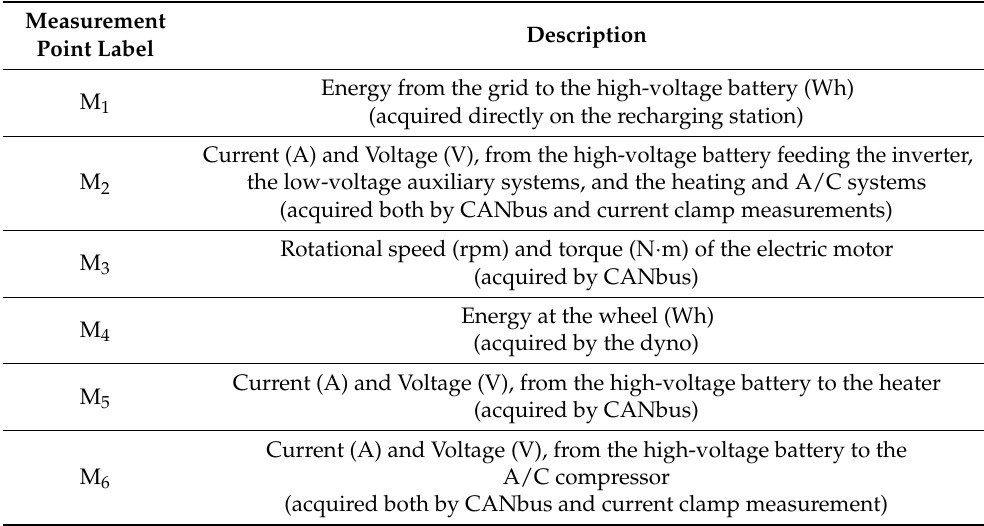
Figure 5. Schematic representation and measurement points. Table 2. Detail of measurement locations [14] (see Figure 5).